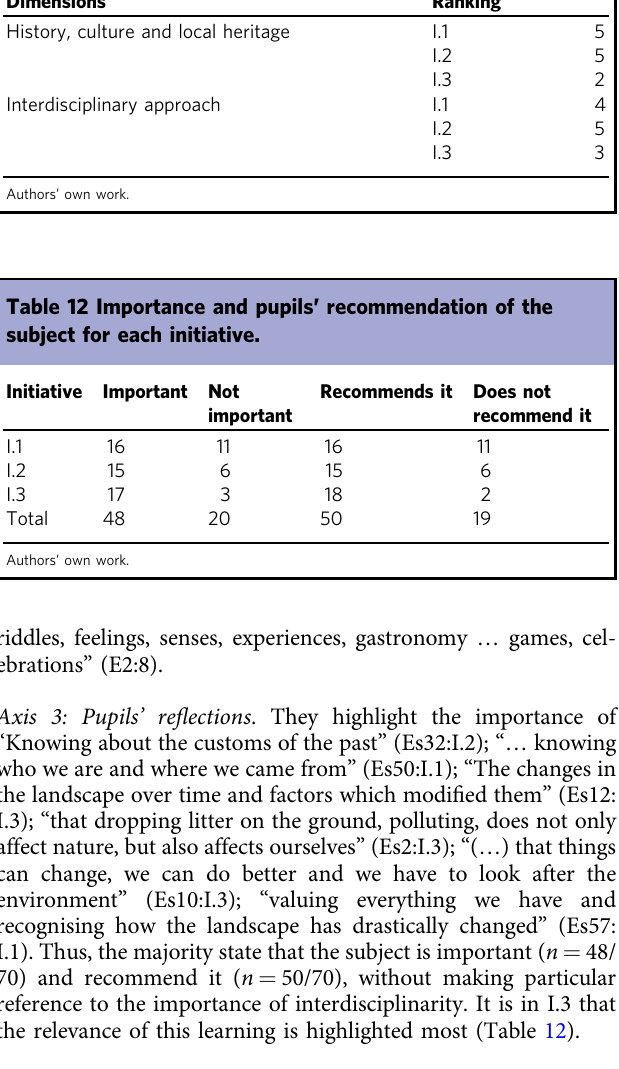
Axis 1: Observation of the teaching and learning process . The three